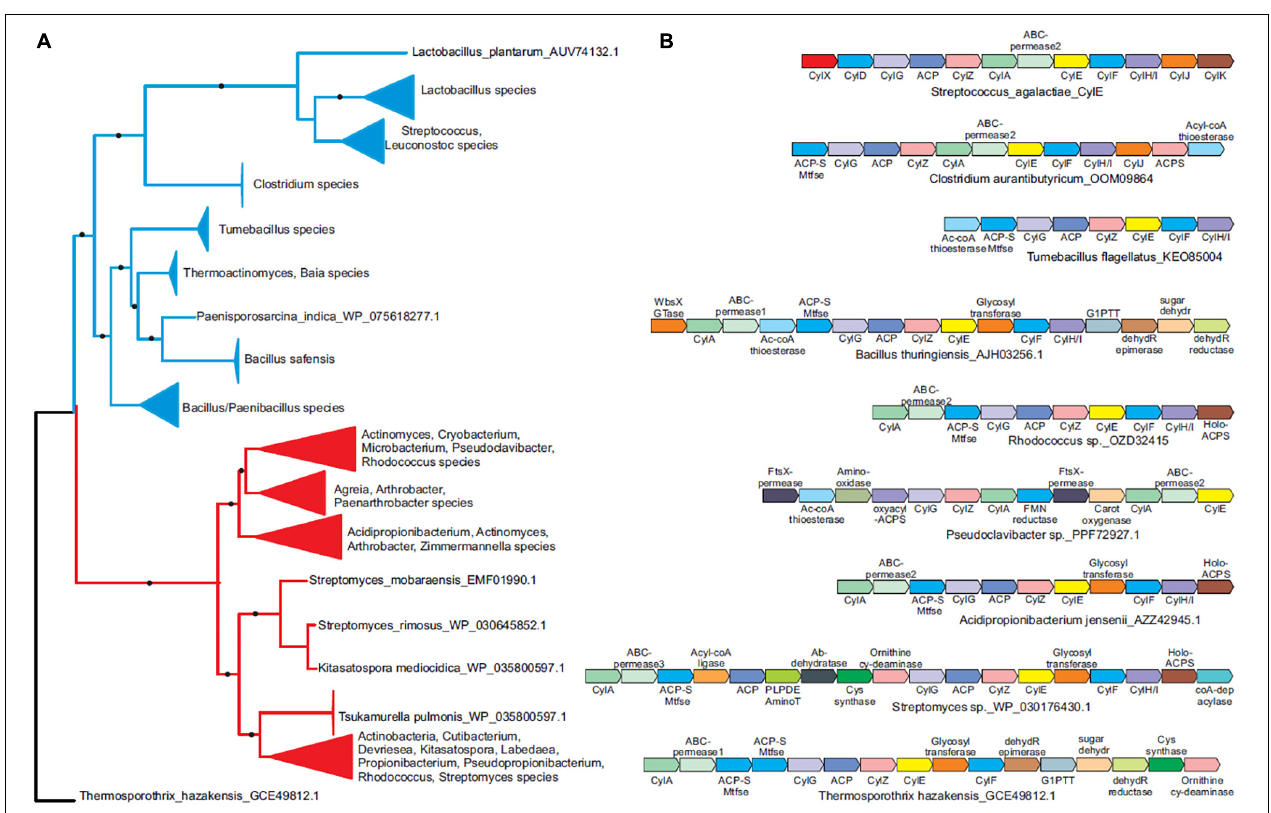
FIGURE 3 | Phyletic analysis suggests the cyl operon evolved prior to the diversification of Gram-positive bacteria. (A) A phylogenetic tree of the CylE protein is shown. Clades with strong bootstrap support were collapsed into filled triangles for convenience (see Supplementary Figure S3 for full tree). Firmicute and actinobacterial branches are colored blue and red, respectively. (B) Representative cyl operons derived from the phylogenetic tree in (A) are shown. Genes are shown as boxed arrows, with the arrow head pointing to the 3 (cid:48) gene. Operons are labeled using the accession number of the cylE gene in the operon. Proteins are denoted using their species names followed by their Genbank accession number or gene